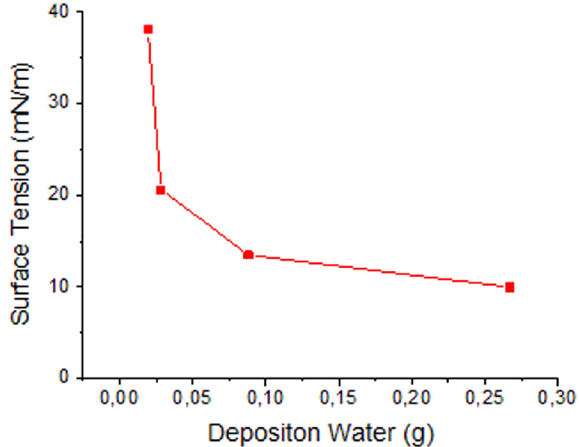
Fig. 7 Experimental design. The samples were then hung one by one at a distance of 10 cm opposite a small fogger machine.